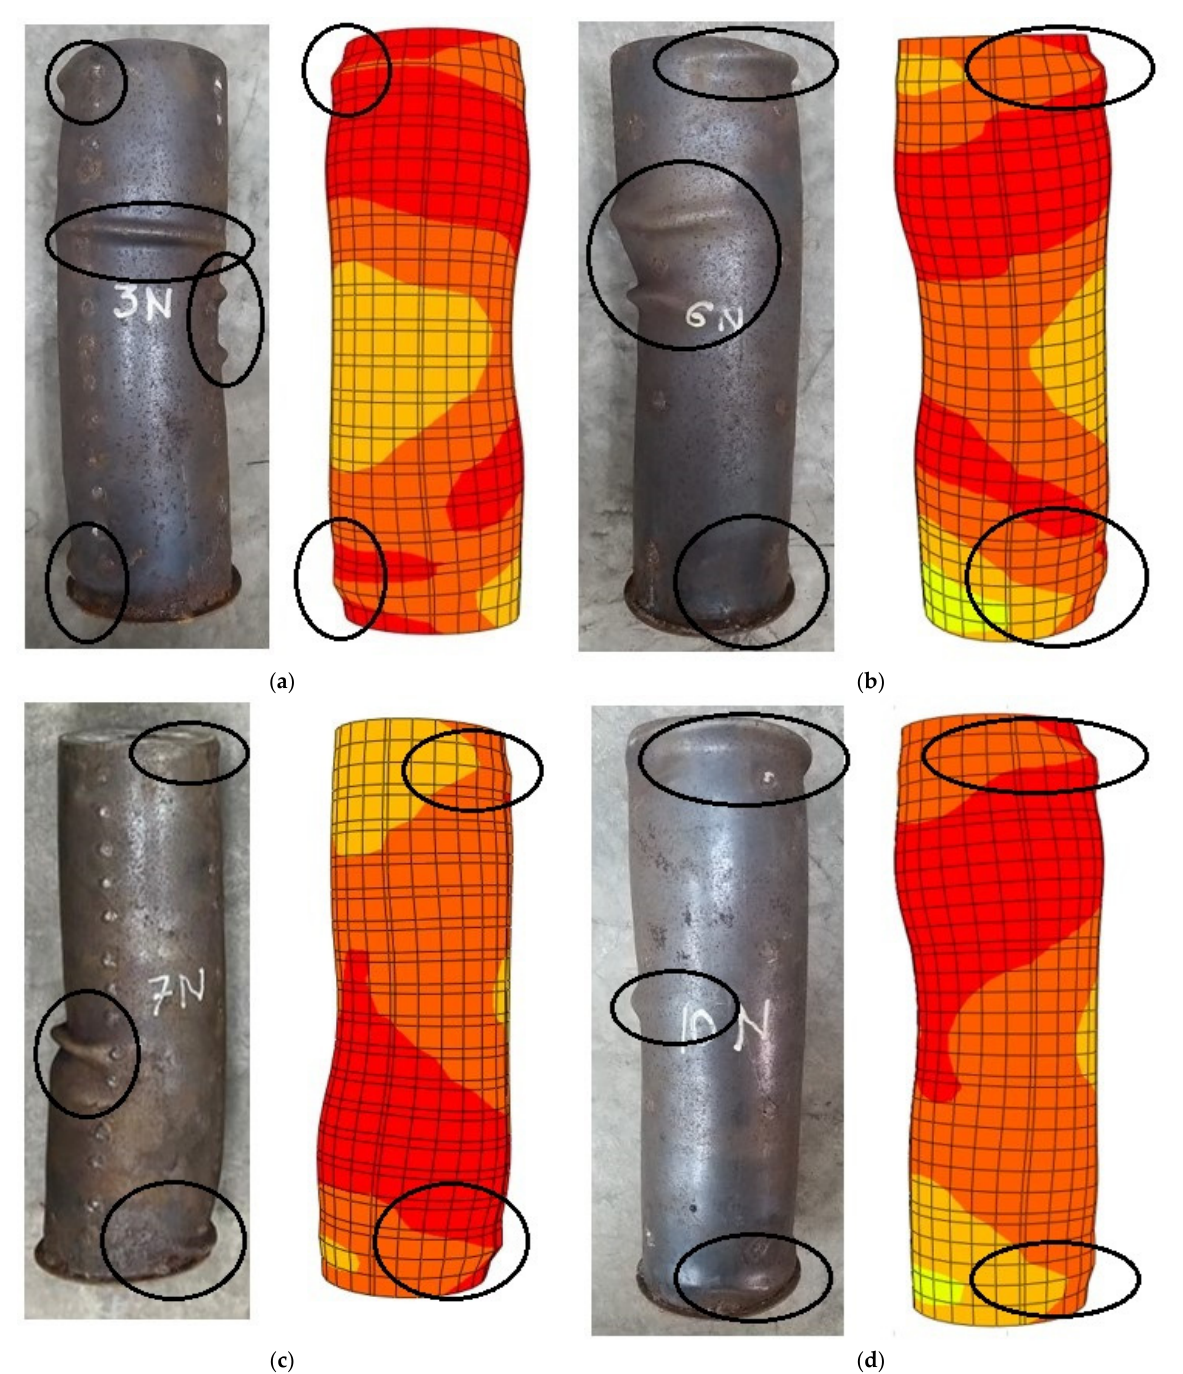
Figure 16. Comparison of the deformation of the circular CFDST with plate stiffeners . ( a )